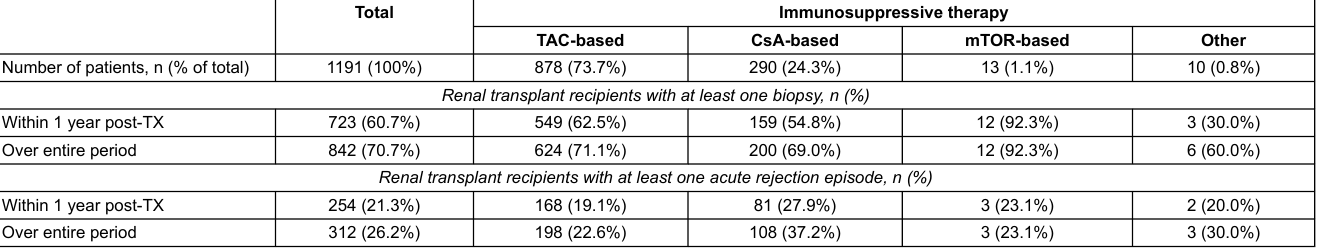
Table 3: Biopsy performance and occurrence of acute rejections in normal-immunological risk patients after renal transplantation